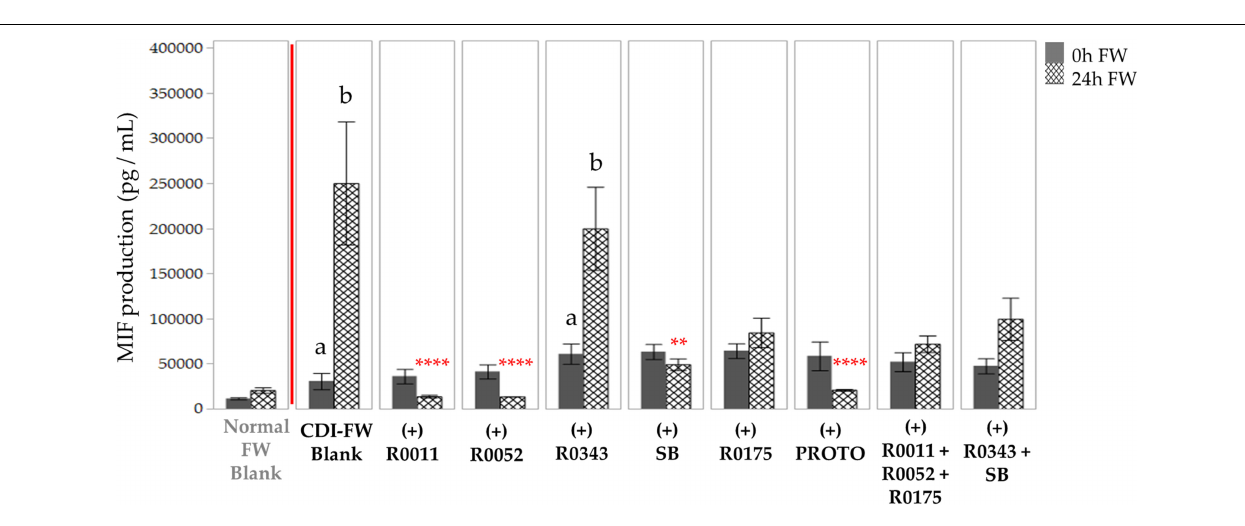
FIGURE 5 | Detection of macrophage inhibitory factor production following the exposure of T84 cells to Clostridioides difficile -infected (CDI) fecal water (FW) treatments. , cells treated with FW collected at T = 0 h; , cells treated with FW collected at T = 24 h. Values are shown as mean ± SEM. Means at time points within treatments not sharing a common letter are significantly different from each other ( p < 0.05). The symbol * represents significant differences (** p < 0.01; **** p < 0.0001) between treatment and CDI-FW blank at T = 24 h. R0011 = L. rhamnosus R0011; R0052 = L. helveticus R0052; R0343 = L. rhamnosus GG R0343; SB = S. boulardii CNCM I-1079; R0175 = B. longum R0175; PROTO = ProtecFlorTM; R0011 + R0052 + R0175 = combination of L. rhamnosus R0011, L. helveticus R0052 and B. longum R0175; R0343 + SB = combination of L. rhamnosus GG R0343 and S. boulardii CNCM